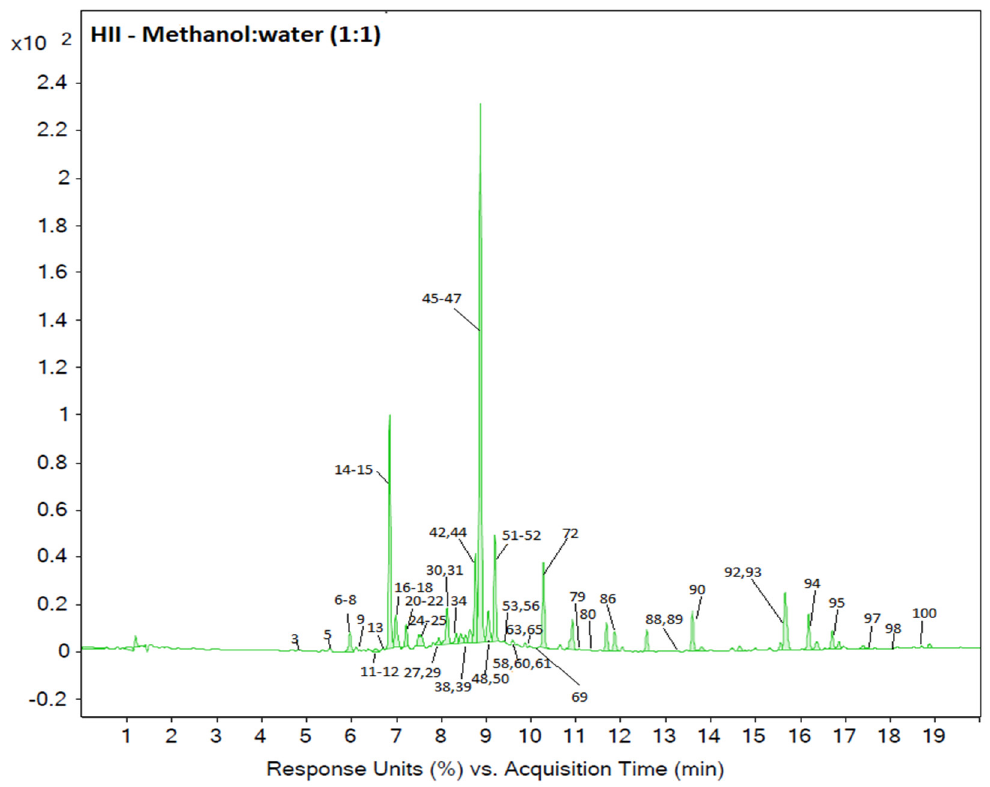
Figure 1. Representative DAD chromatogram (280 nm) of a H. italicum ssp. italicum ( HII ) sample with peak annotations representing identified compounds. Numbers correspond to each identified compound, listed in Appendix A, Table A1.